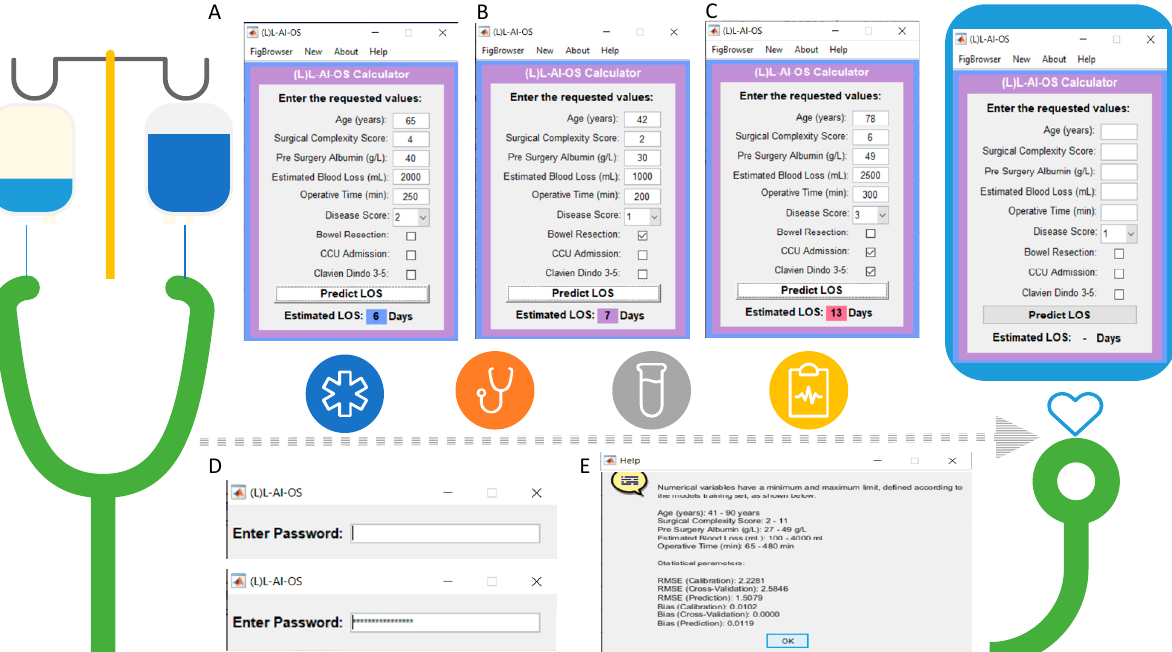
Figure 5. Graphical User Interface (GUI) presentation of the Leeds L-AI-OS score. ( A – C ): The (L)-LAIOS button navigates to the feeder interface. The length of stay (LOS) index assigns weighted risk points to each significant factor in a scoring system to predict hospital stay ( D ) The GUI is password protected. ( E ) The help button routes to more information about the prediction model including the values of the numerical variables and the statistical parameters.